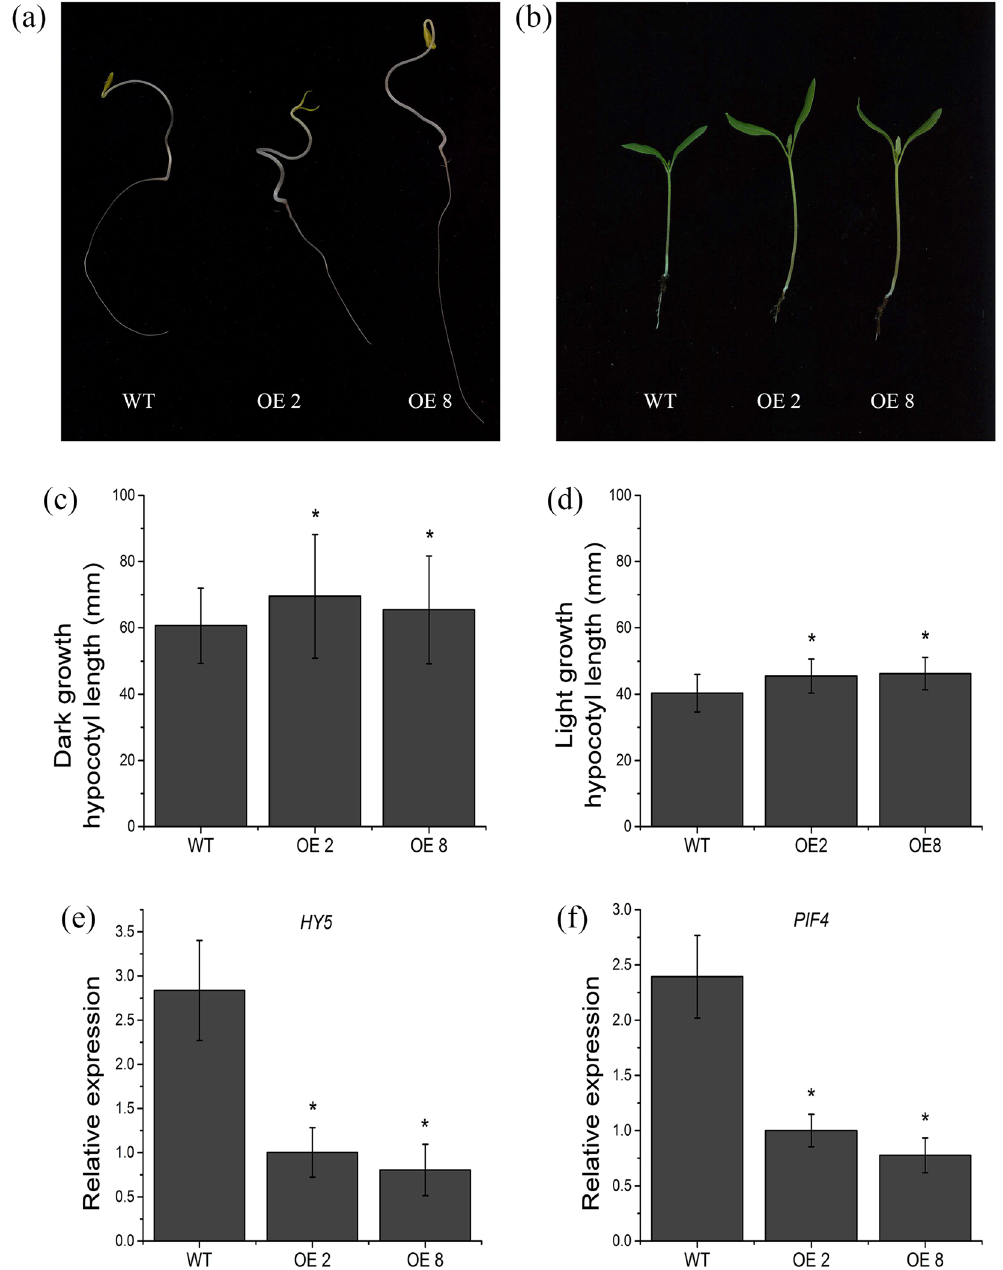
Figure 5. Phenotype of 35 S:PRE2 seedling and expression analysis of HY5 and PIF4 . ( a ) and ( b ) photograph of seedling of two 35 S:PRE2 lines and wild type obtained at 8 days after sowing under dark and light condition, respectively. ( c ) and ( d ) hypocotyl length of two 35 S:PRE2 lines and wild type 8 days seedlings growing in dark and light condition, respectively. ( e ) and ( f ) respectively represent expression levels of HY5 and PIF4 in 8-days- old dark-grown seedlings. Data are the mean ± SD of three biological replicates. * Significantly different from the wild type, P < 0.05; ** for P <